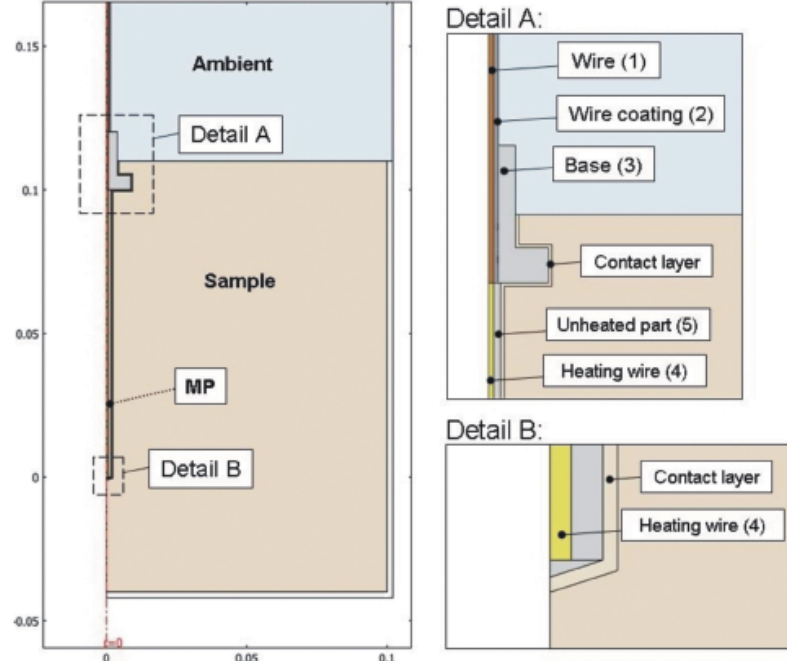
Fig. 16. Model of the LNP03-sensor (short thick needle) embedded in a